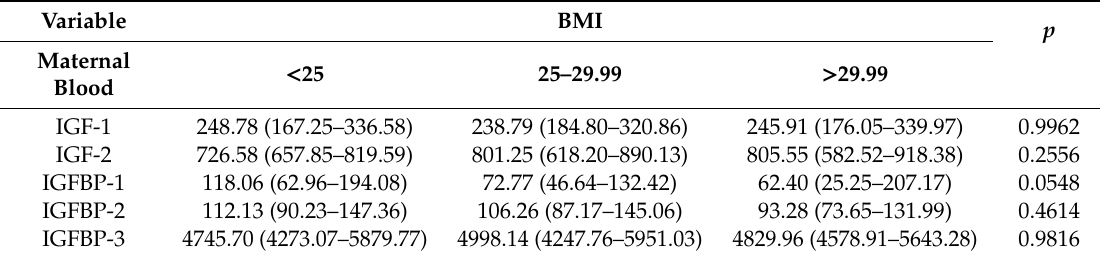
Table 5. Comparisons of studied laboratory markers according to adult GDM body weight classification based on